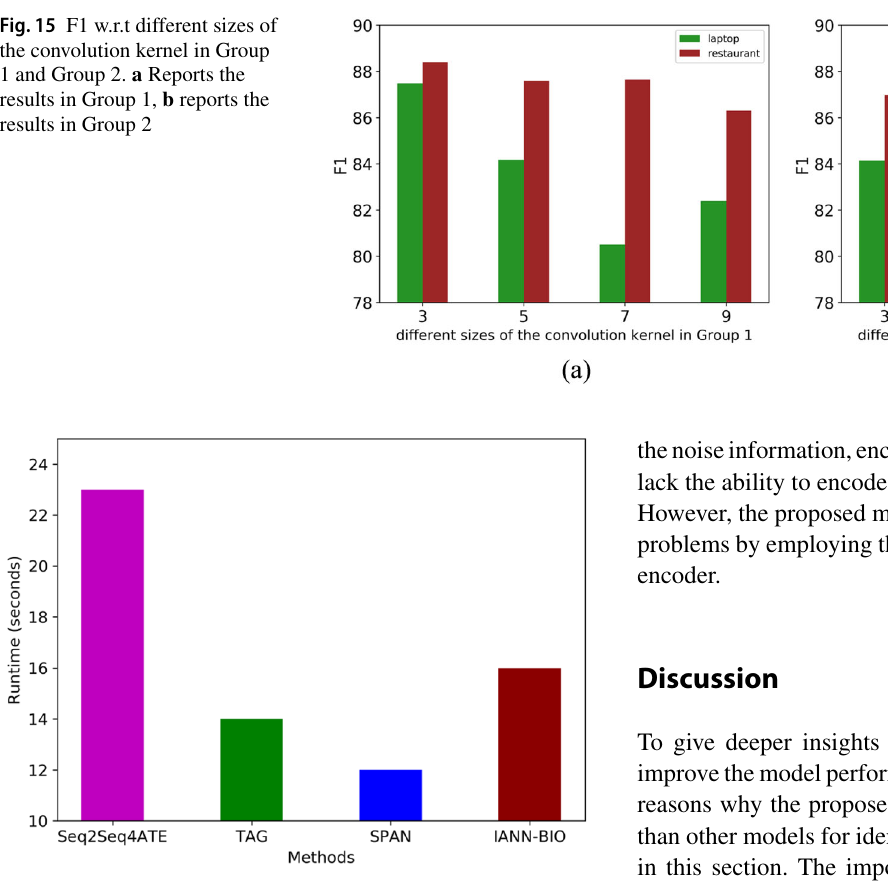
Fig. 16 Running time of one epoch of different methods in the training stage on the laptop